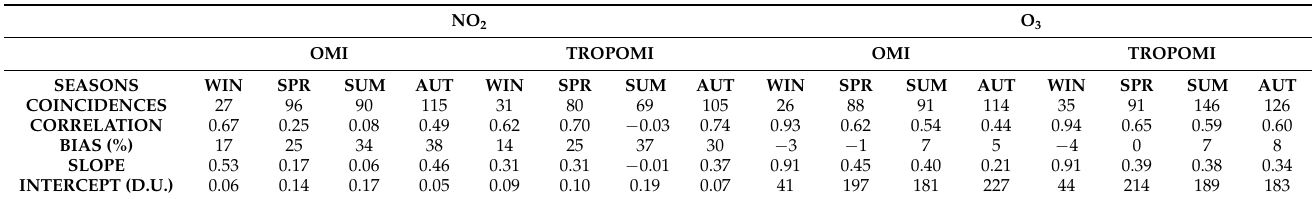
Table 4. Statistical parameters of the comparisons between ground-based DOAS and satellite VCDs with a spatial radius of 20 km and for different